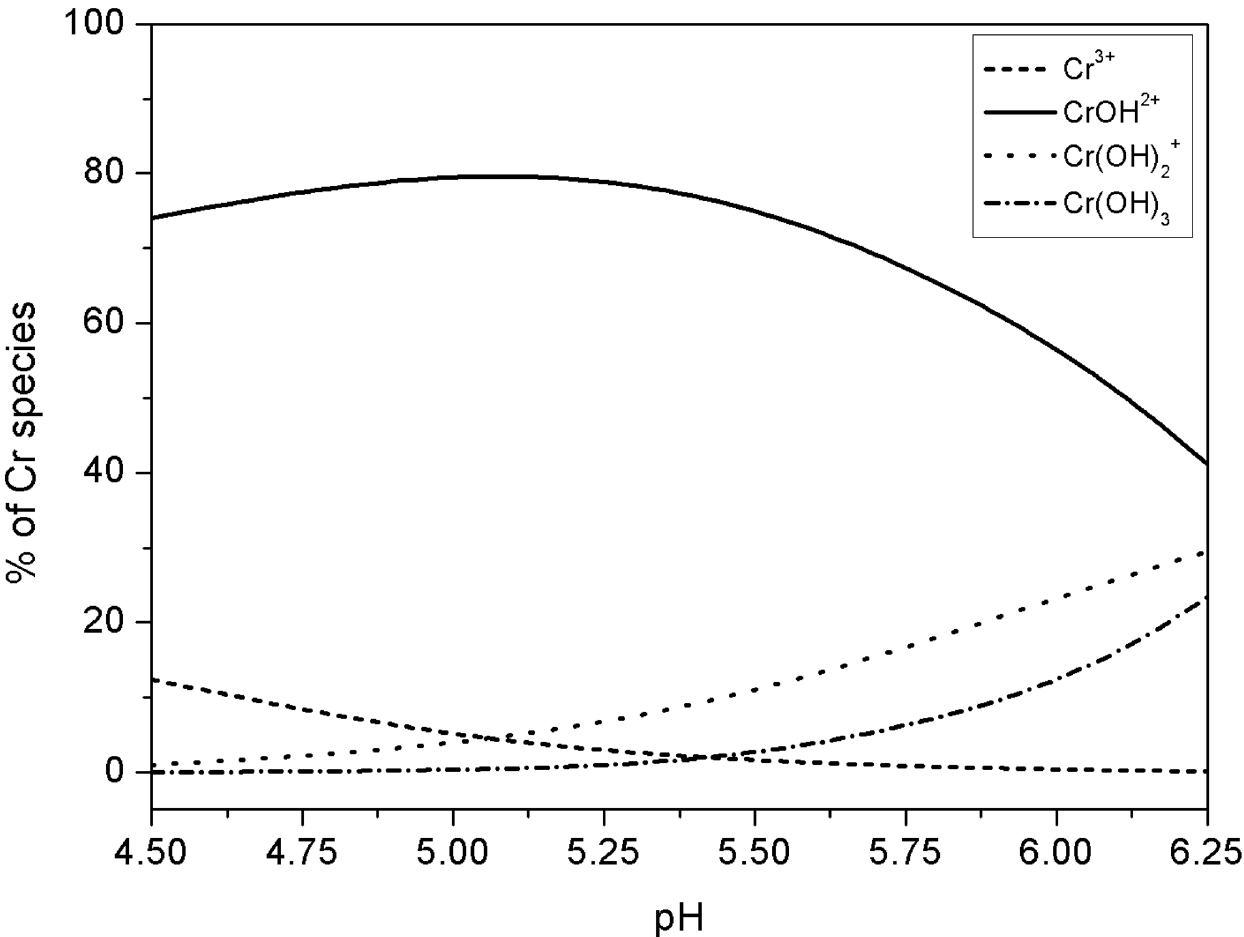
Figure 1. The distribution of different Cr(III) species (%) as a function of pH calculated by Visual MINTEQ.